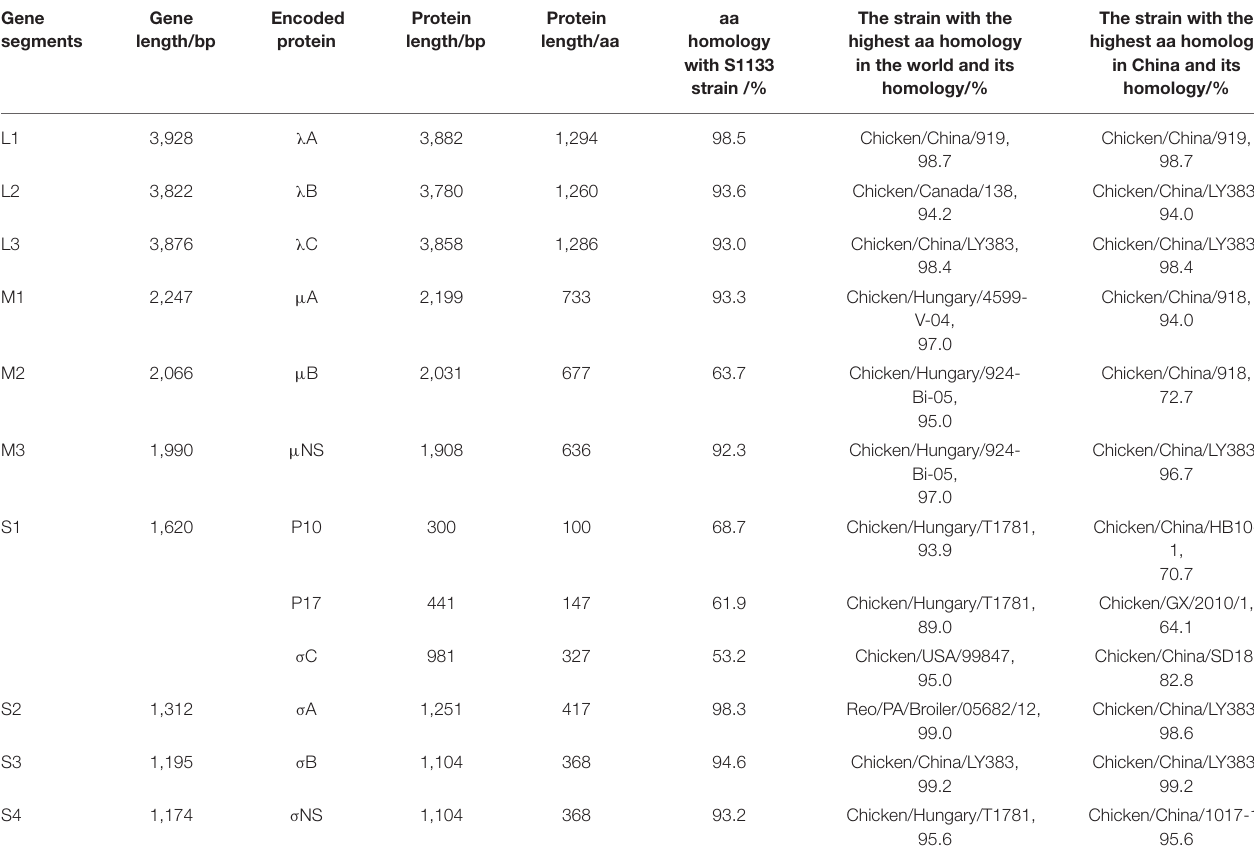
TABLE 4 | Genomic characteristics of